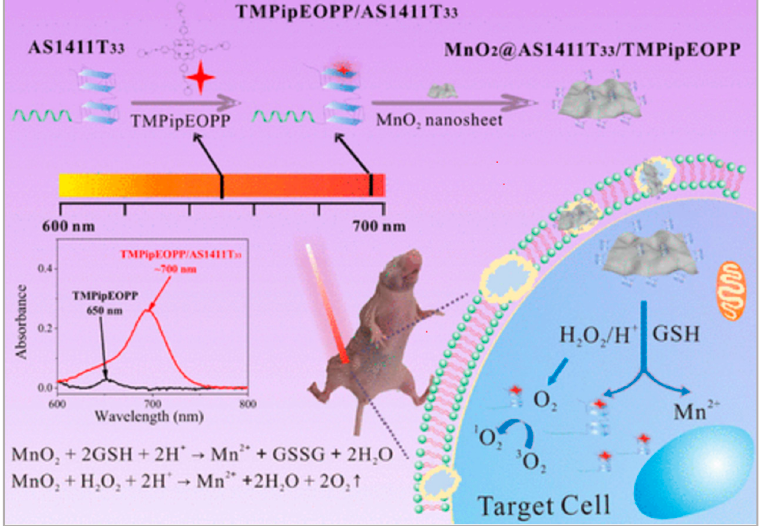
Figure 10. Preparation of G-quadruplex/porphyrin composite photosensitizer and its application in PDT treatment of solid tumors after assembly with MnO2 nanosheet. Reprinted with permission from [118]. Copyright © 2019 American Chemical